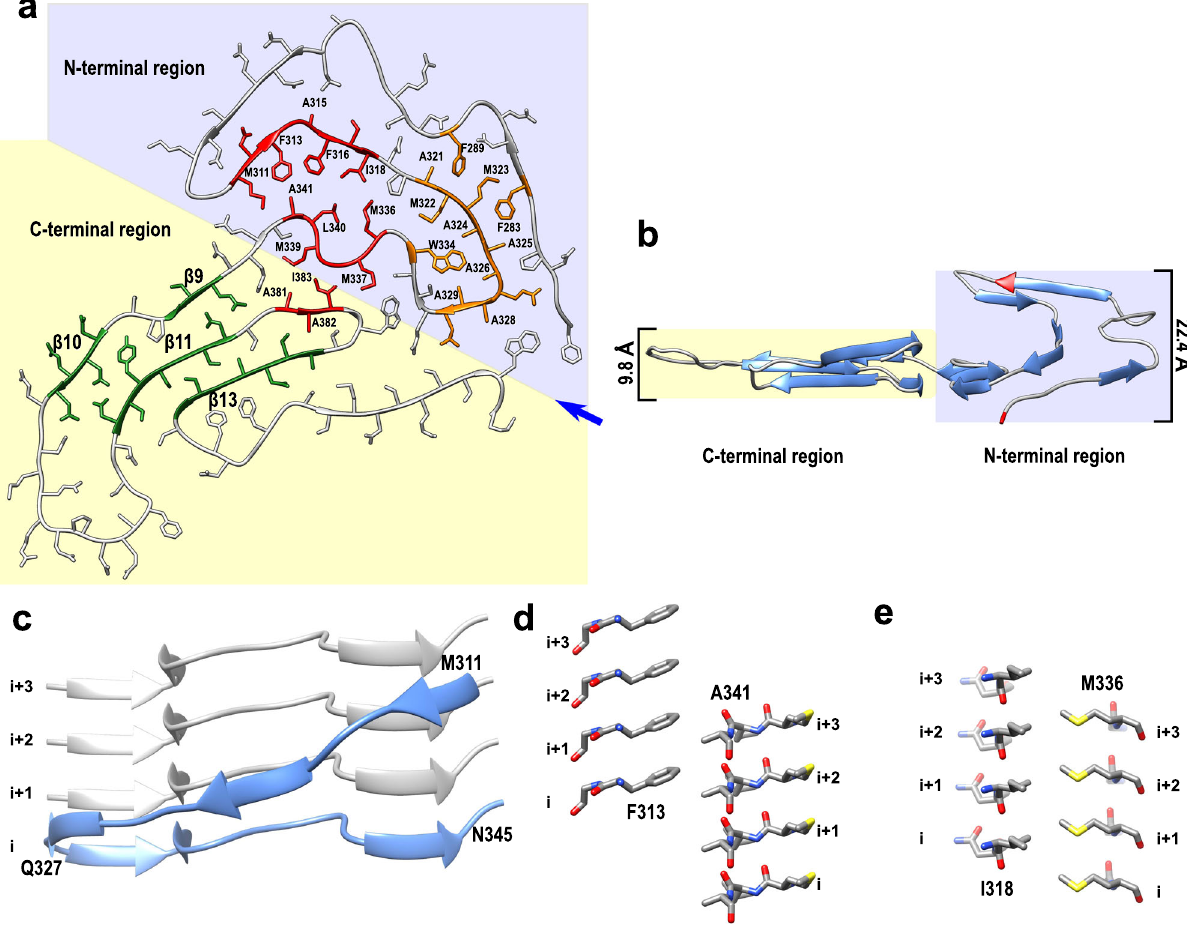
Fig. 2 Differences between the N- and C-terminal regions of the amyloid core of TDP-43 LCD fi brils. a Top view of one subunit within the fi bril. Large (red) and smaller (orange) hydrophobic cores are present within the N-terminal part, stabilizing this region. The C-terminal region is stabilized largely by steric – zipper interactions involving side chains within strands β 9, β 10, β 11, and β 13 (green). b Side view of one subunit within the fi bril (with the view angle indicated by the blue arrow in a ). In contrast to a largely planar C-terminal region, the N-terminal region extends along the fi bril axis over the distance of 22.4 Å. The lowest (Phe276) and the highest (Asn306) points are marked in red. c Side view of the 311 – 327 segment extending along the fi bril axis. This segment in subunit i interacts with the 327 – 345 segment in subunits i + 1, i + 2, and i + 3. d , e Side view of interlayer interactions between F313 and A341 ( d ) and I318 and M336 ( e ). Layers of side chains are packed in a staggered fashion, resulting in a very compact hydrophobic